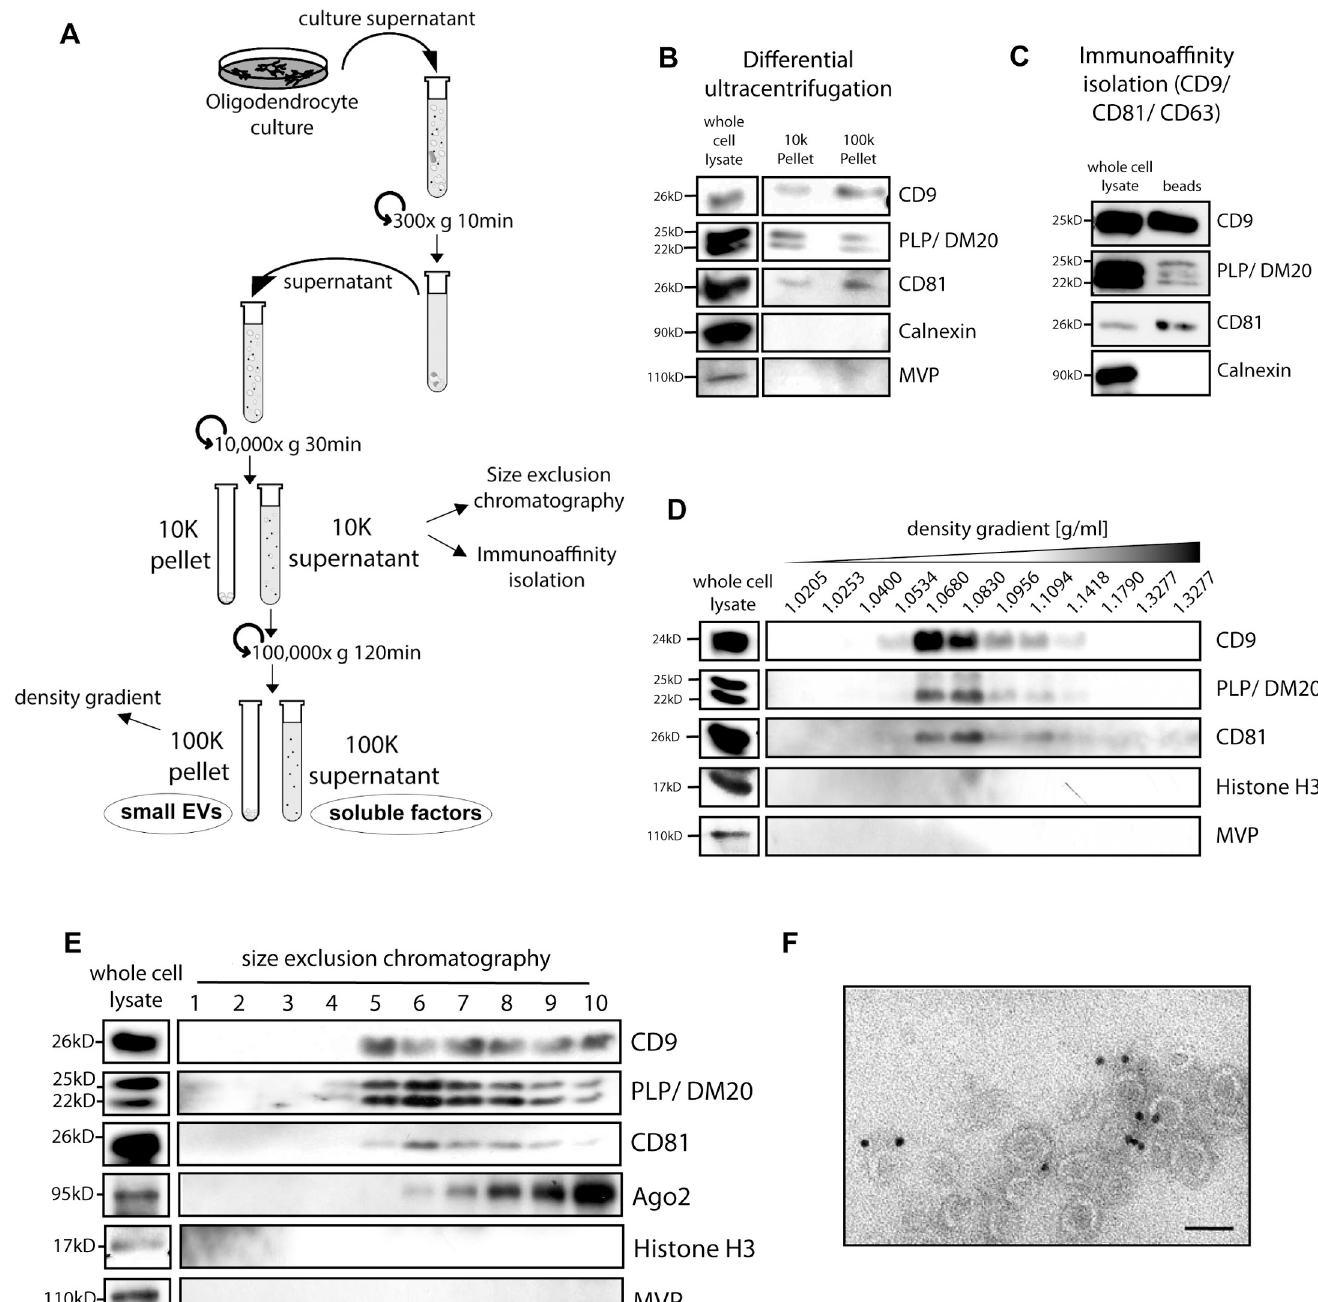
Fig 1. Characterization of oligodendrocyte-derived sEVs. (A) Schematic illustration of differential ultracentrifugation and the generation of 10K and 100K supernatants and pellets. (B–E) Western blot analysis of sEVs isolated by differential ultracentrifugation (B), immuno-bead isolation from 10K supernatants (C), density gradient centrifugation of 100K pellets (D), or size exclusion chromatography of 10K supernatant (E). Underlying images of blots can be found in S1 Images. (F) Immuno-transmission electron microscopy micrograph depicting MAG-labeled sEVs characteristic of exosomes in the extracellular space of cultured oligodendrocytes (MAG is an oligodendroglia-specific membrane protein present in exosomes). Bar, 100 nm. 10K, 10,000 g- centrifuged; 100K, 100,000 g- centrifuged; EV, extracellular vesicle; MAG, myelin-associated glycoprotein; PLP, proteolipid protein; sEV, small extracellular vesicle.